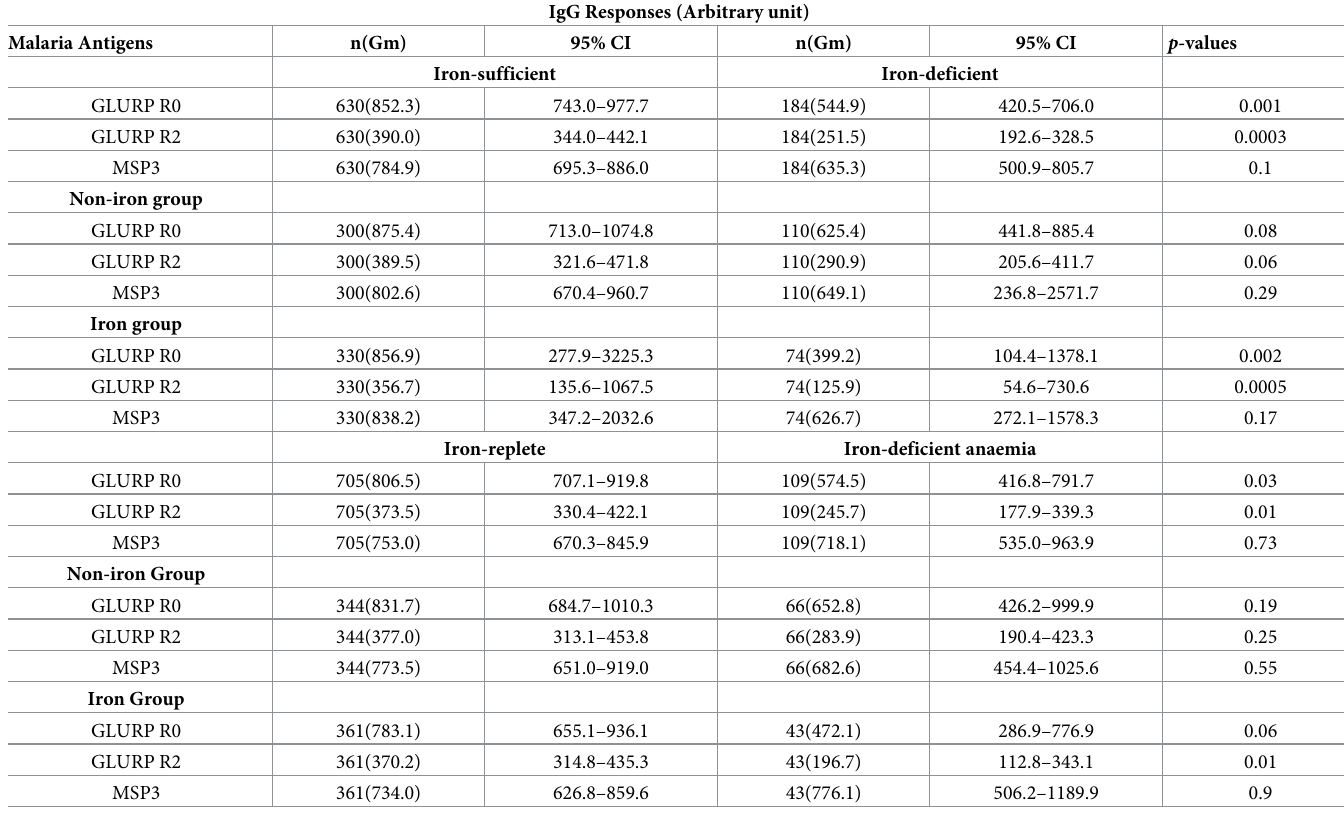
Table 3. Malaria antigen-specific IgG responses on anaemia and iron status.